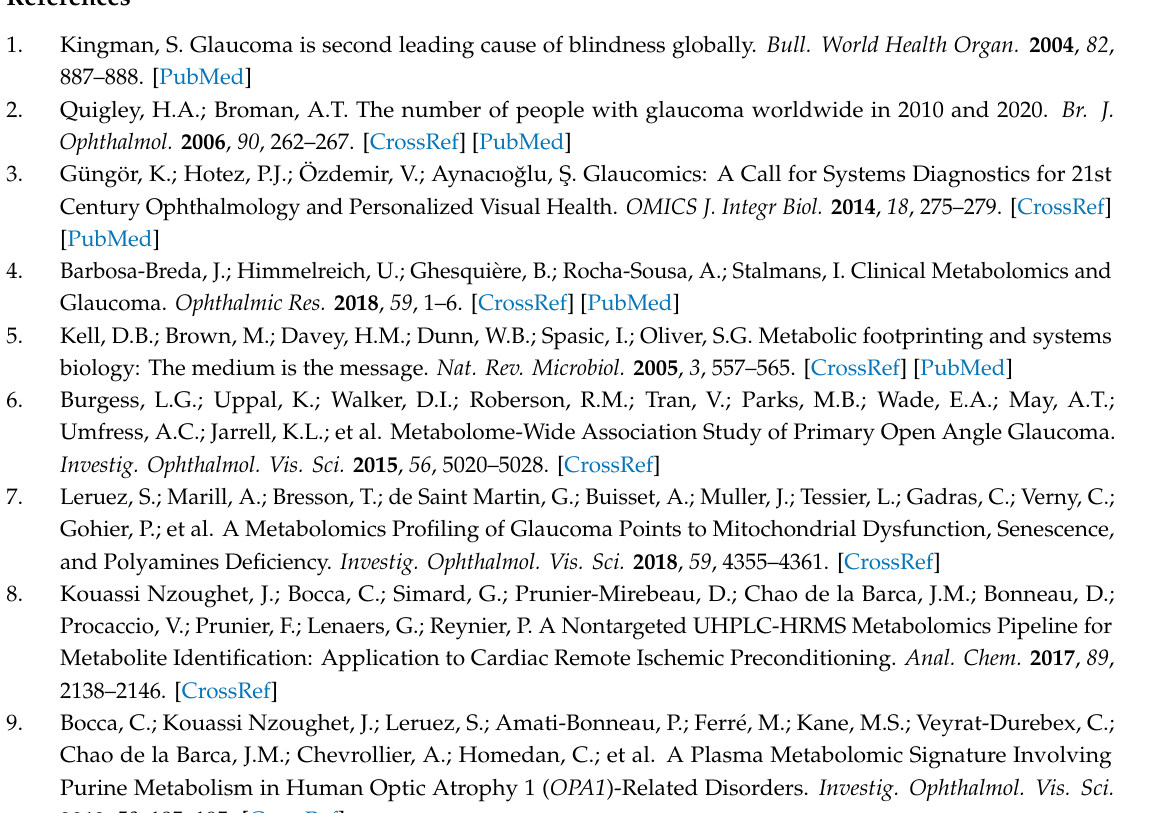
Figure S1: PCA applied to the 160 identified features in the initial cohort, Figure S2: Score plot for Orthogonal Projection of Latent Structures Discriminant Analysis (OPLS-DA) model based on the entire dataset, Figure S3: S-plot for biomarkers selection, Figure S4: Histogram of the area under the ROC curve (AUC) versus the number of LASSO models, Figure S5: LASSO model, Table S1: Data matrix after